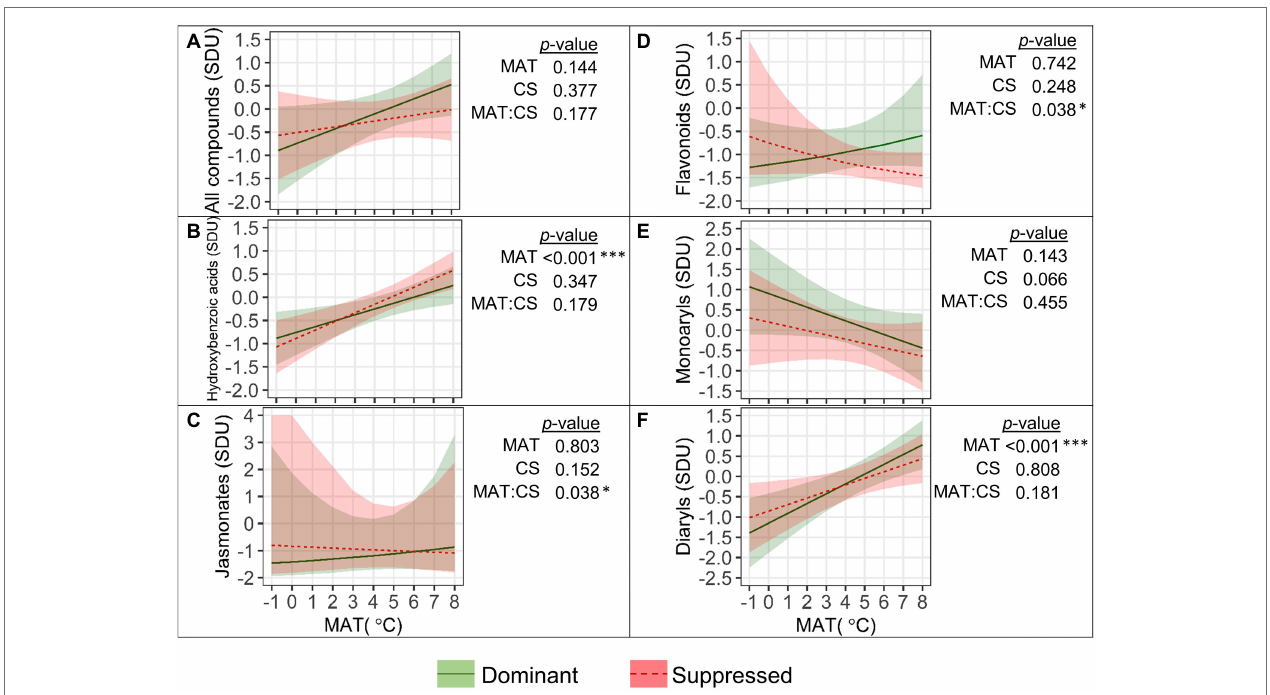
FIGURE 6 | Relationships between the quantity (SDU, standard deviation units) of all fine root secondary metabolite compounds (A) and groups of compounds (B–F) with mean annual temperature (MAT) in competitively dominant and suppressed silver birches (predicted mean trend with 95% confidence bands based on LMM). Curvilinear trendlines indicate that data were log -transformed prior to LMM analysis and the model predictions were back-transformed for data visualization. The significance of the factors (MAT; CS, competitive status) is shown next to the graphs: * p < 0.05, *** p < 0.001.